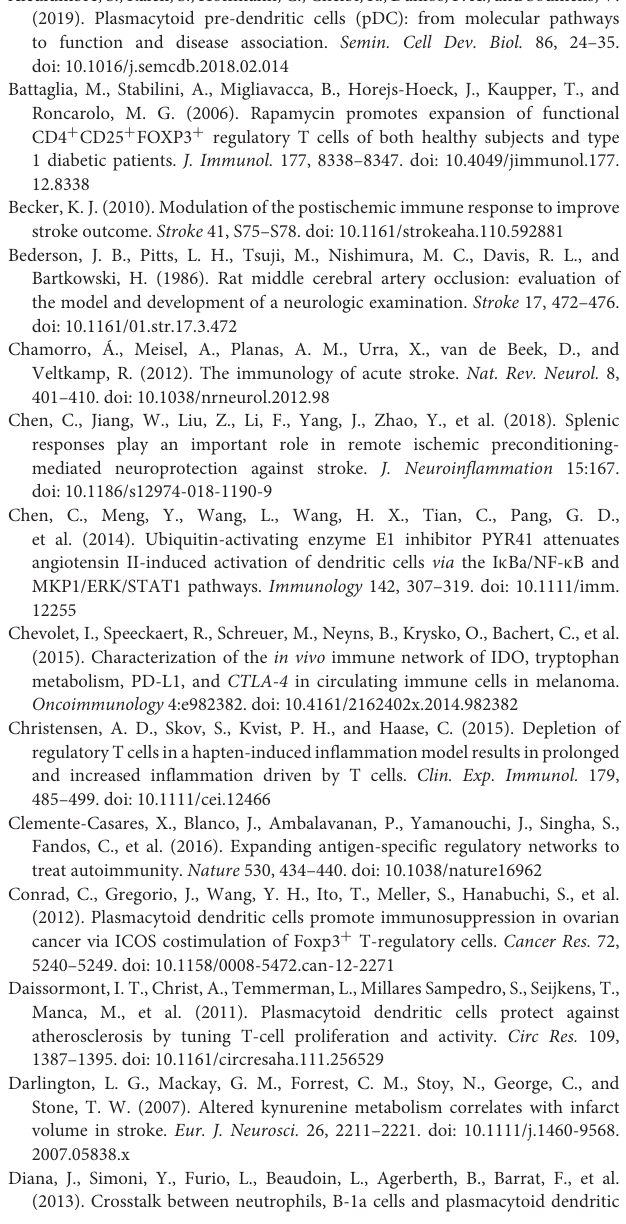
TABLE S1 | Statistics of experiment animals in each group. The animals showing no obvious sign of neurological deficits (neurological deficit score less than 2) were